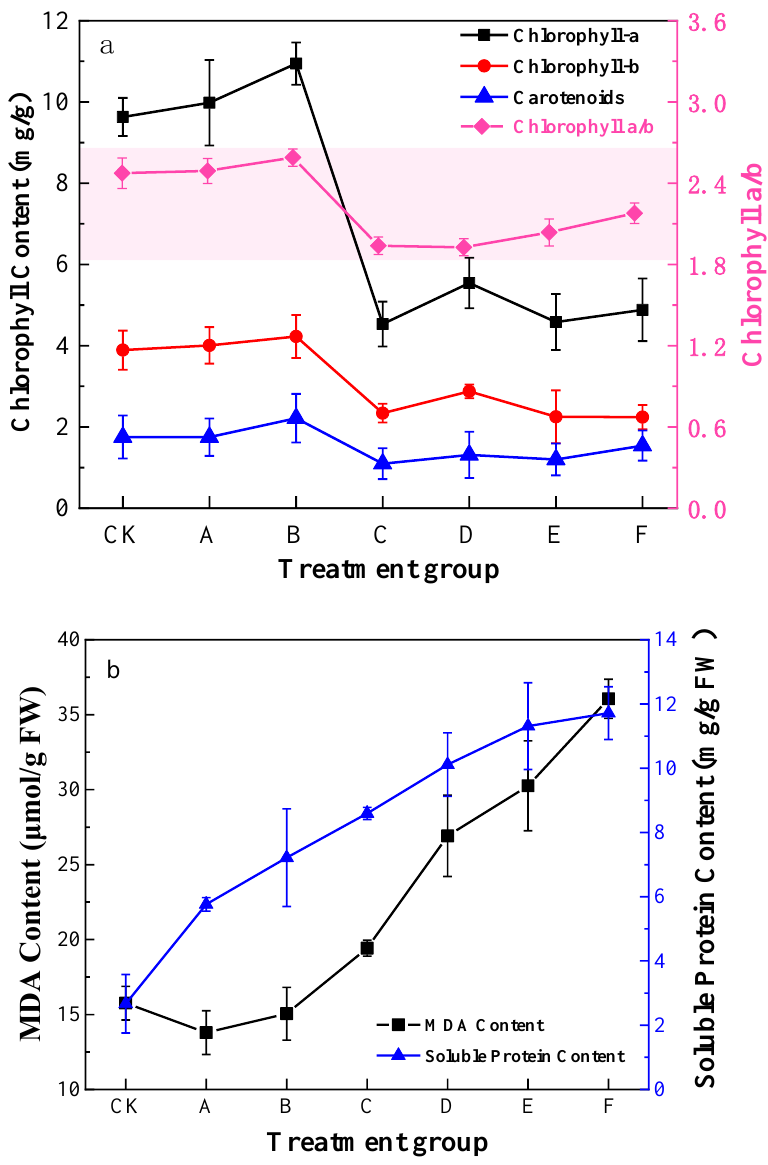
Figure 1. Pb stress on chlorophyll ( a ) and MDA content and soluble protein content ( b ) in the K. paniculata leaf under different treatment groups.